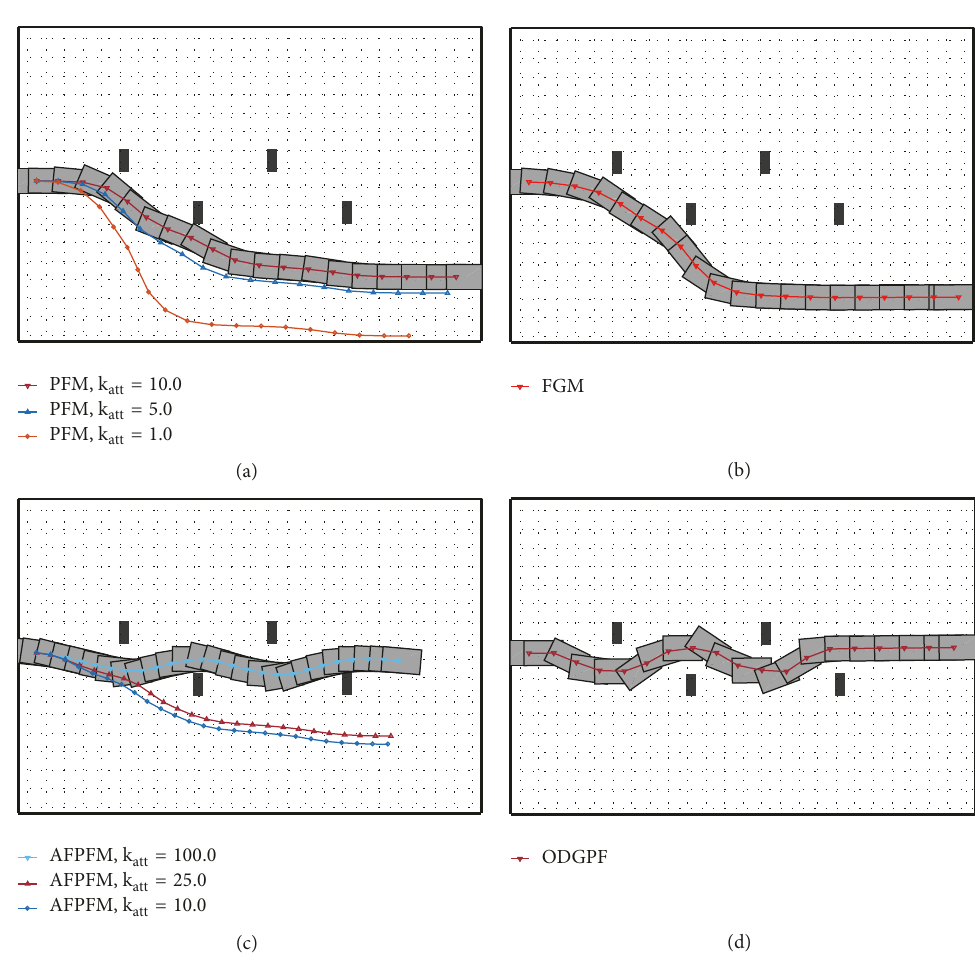
Figure 11: Simulation results under static environment: (a) PFM, (b) FGM, (c) AFPFM, and (d)